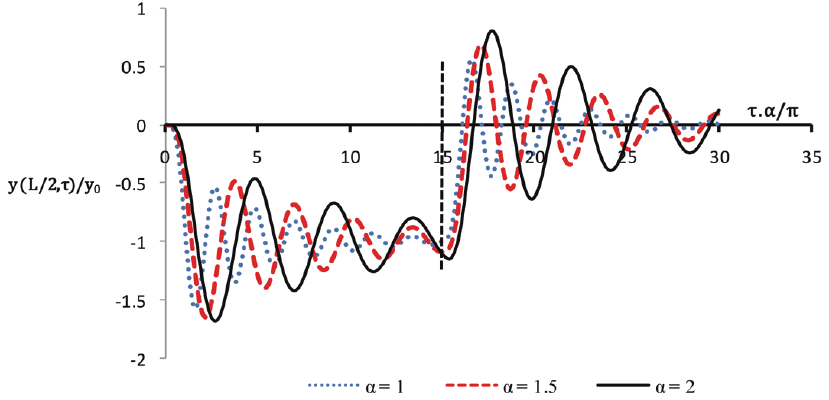
Fig. 13. DLF in terms of τ · α/π for K = 1, E 1 = 0.75 and α (cid:2)